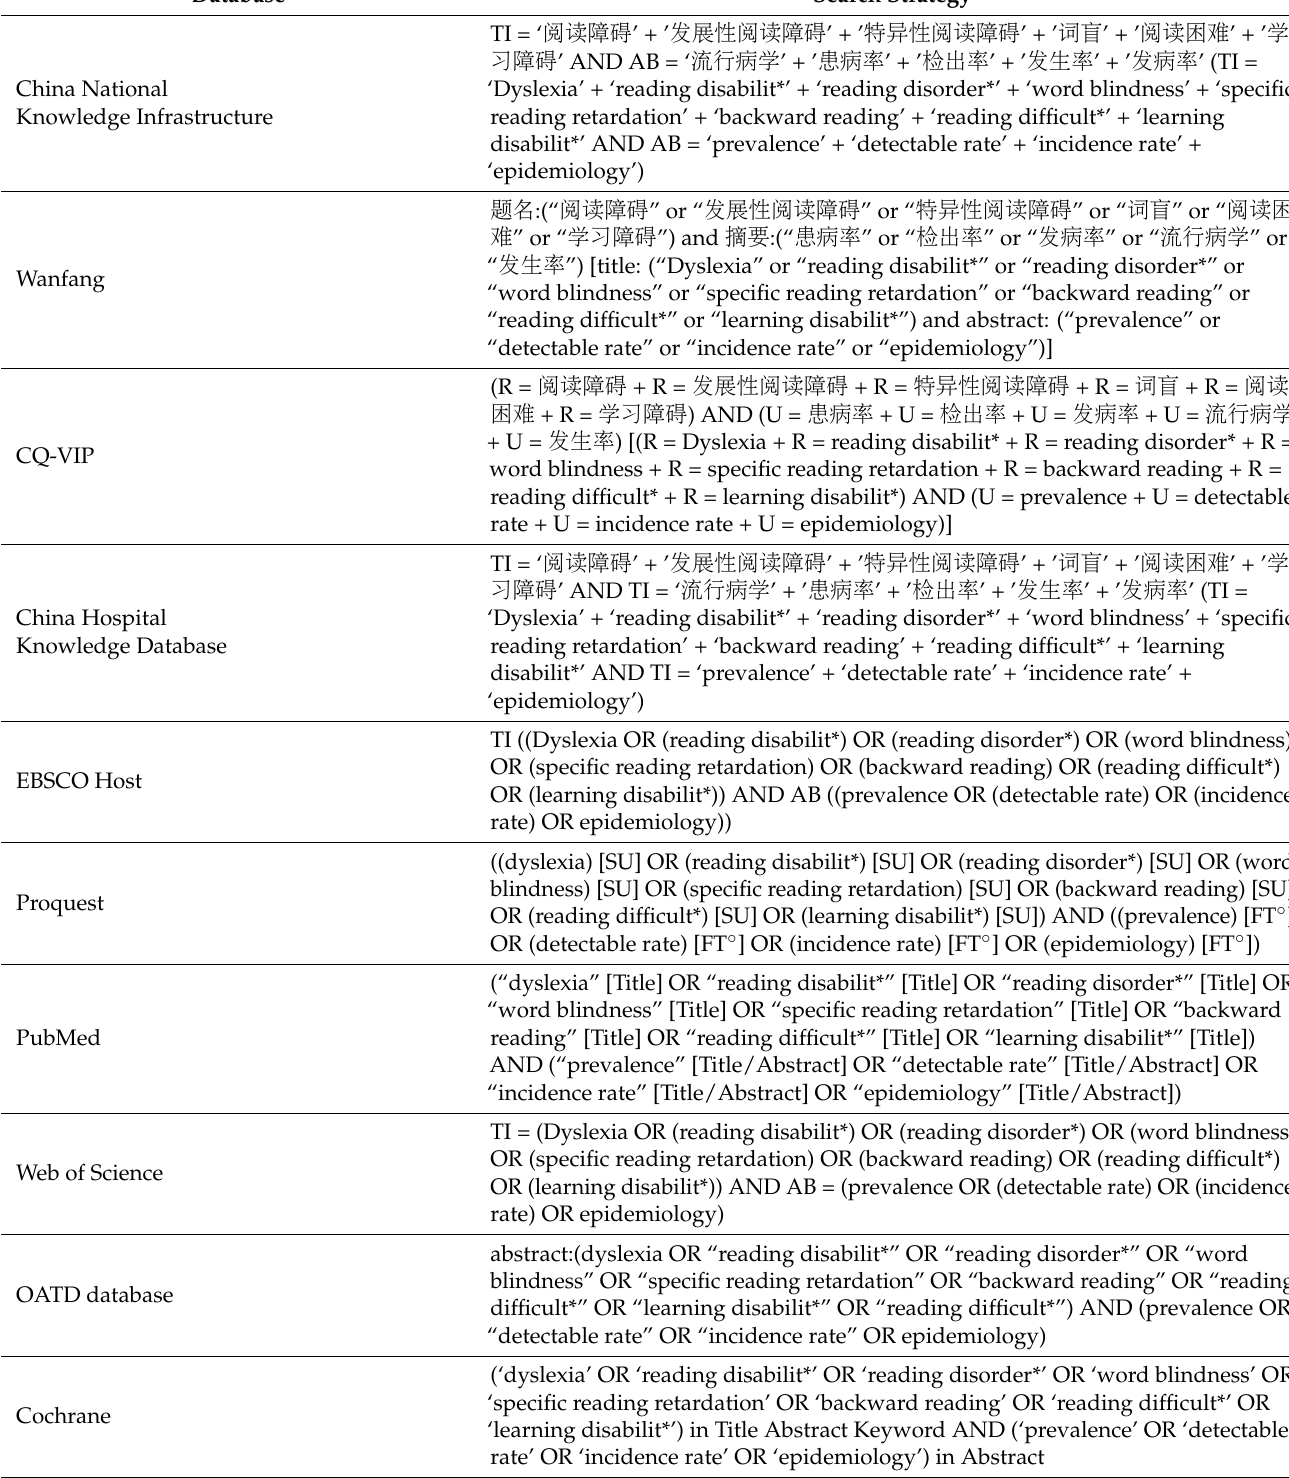
Table A1. Search